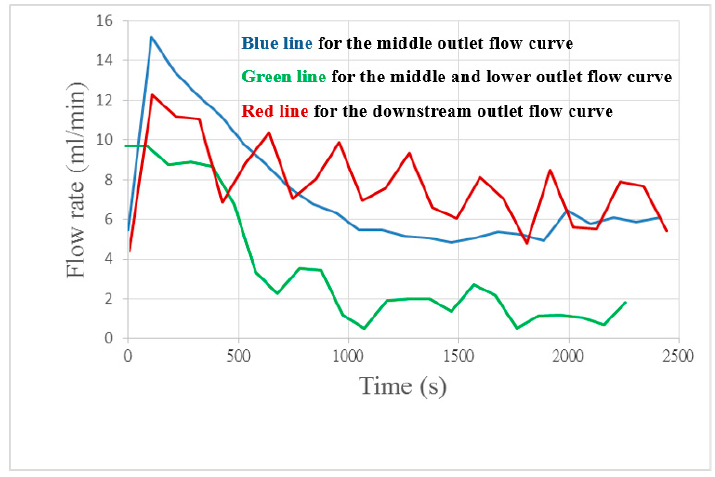
Figure 8. Flow curve diagram of different runners.